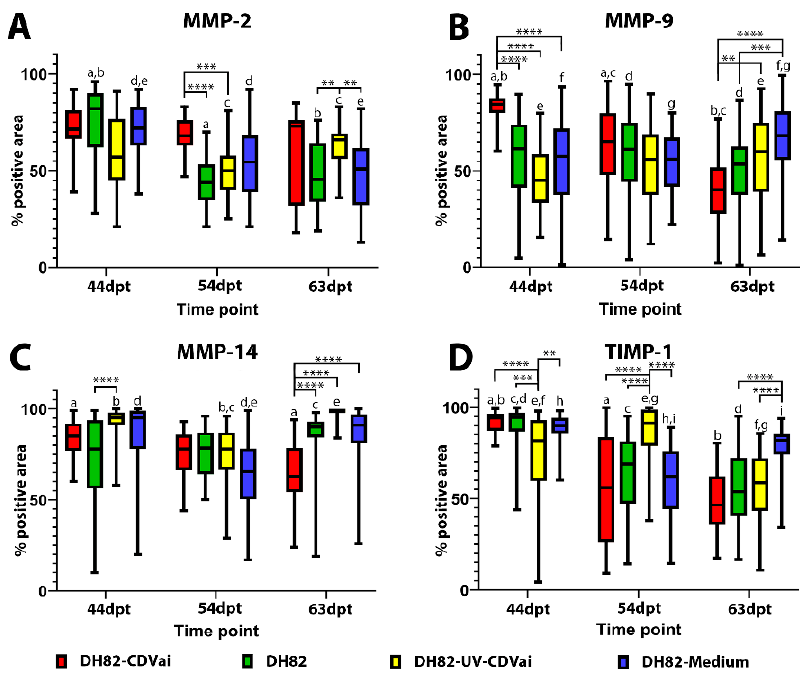
Figure 9. Comparative illustration of the percentage of immunolabeled tumor tissue within the periphery of non-infected (DH82), intratumorally canine distemper virus (CDV)-infected (DH82-CDVai), intratumorally UV-inactivated CDV-injected (DH82-UV-CDVai) and intratumorally medium-injected (DH82-medium) xenografts. The graphs show the percentage of ( A ) matrix metalloproteinase (MMP)-2, ( B ) MMP-9, ( C ) MMP-14 and ( D ) their inhibitor (TIMP)-1 immunolabeling over time (days post-transplantation, dpt). All graphs represent Box and whisker plots with statistically significant differences between different groups at the same time point (** p ≤ 0.01, *** p ≤ 0.001, and **** p ≤ 0.0001) and between different time points within the same group (a–i; p < 0.05).